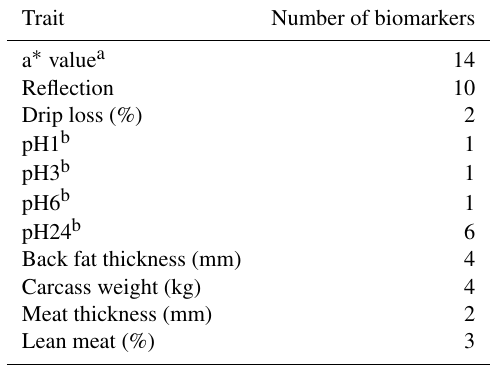
Table 1. Number of biomarkers found per trait in a German high- quality fresh pork Pietrain selection